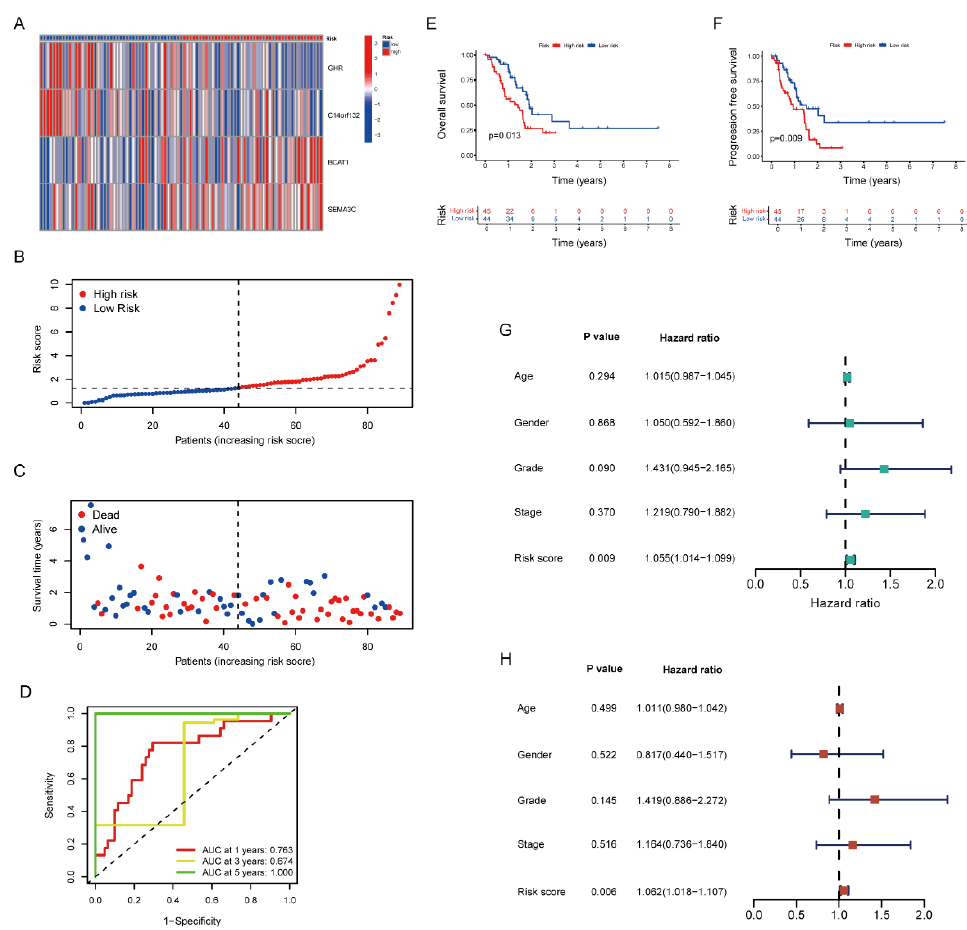
Figure 5. The Prognostic Value of Stroma- and Metastasis-Associated Risk Score Model in the Testing Group. ( A ) The heat map illustrated the expression of four genes in each sample. ( B ) The distribution of low- and high-risk samples. ( C ) The correlation of risk score, survival status and survival time ( D ) ROC curve of the risk score. ( E , F ) Kaplan–Meier curve of overall survival and progression-free survival in low- and high-risk groups. ( G , H ) The univariate and multivariate Cox regression analysis of clinical characteristics and risk score.